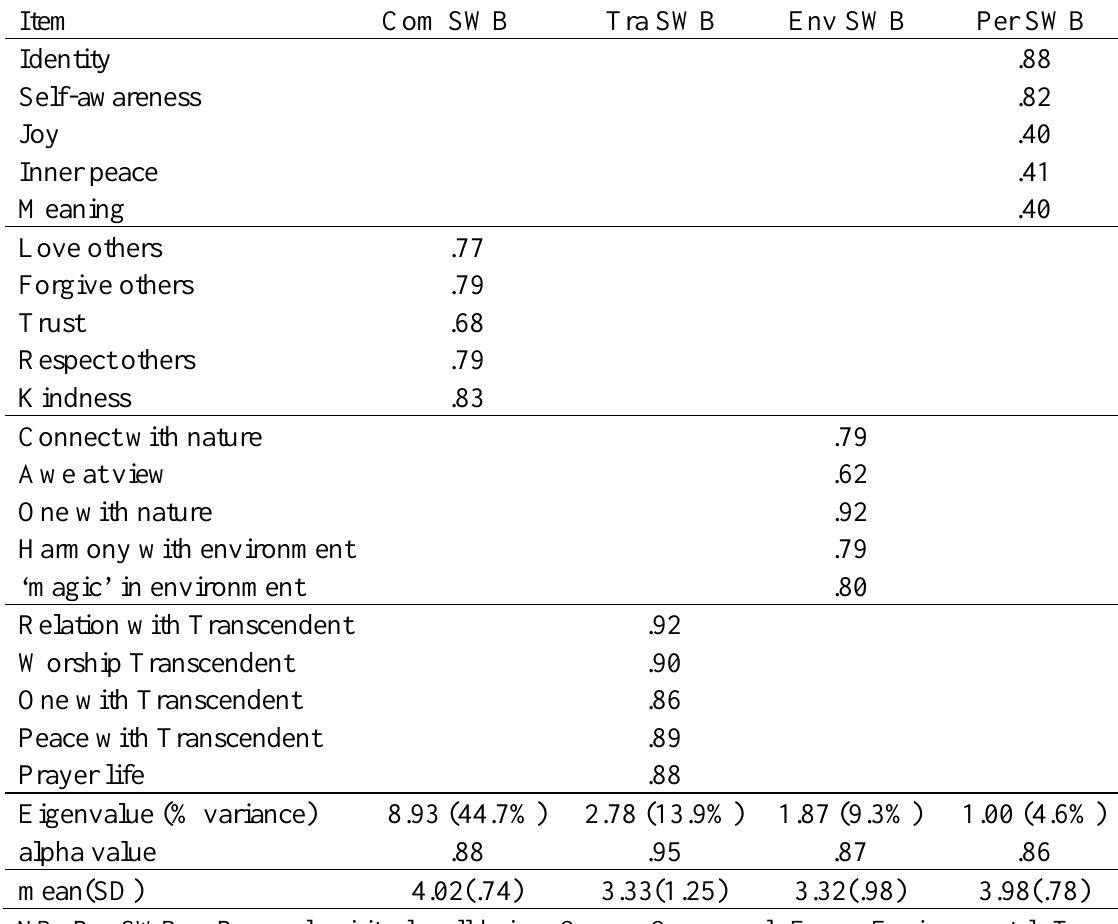
Table 2. Pattern matrix for PCA with Oblimin Rotation of 4-factor solution of generic SHALOM items, together with Cronbach’s alpha coefficient for reliability analyses of